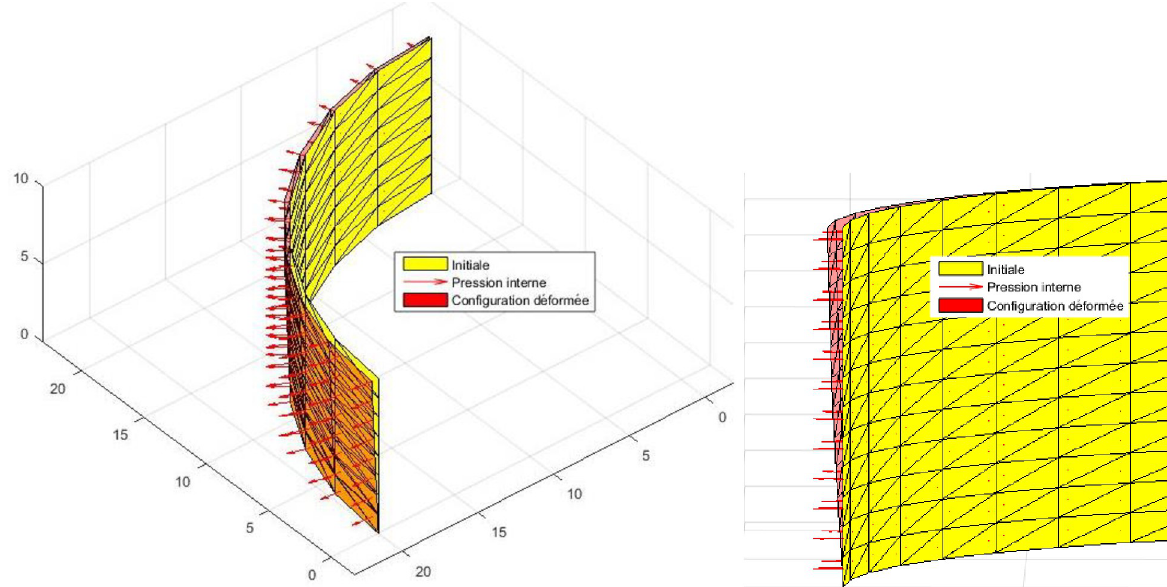
Fig 9. Isometric view of initial configuration and deformed 1/8 of the cylinder.